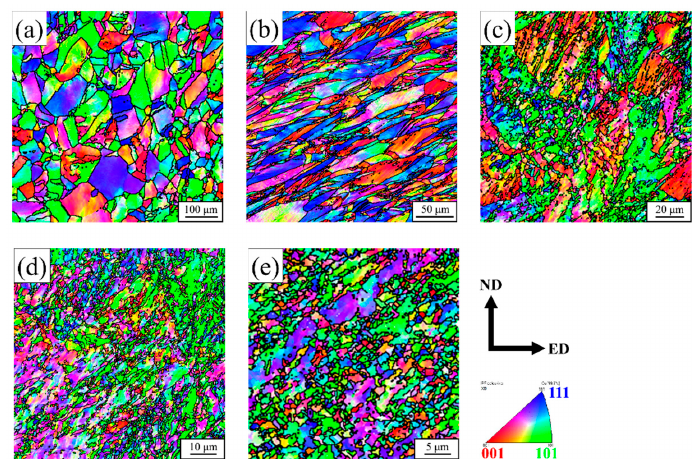
Figure 4. Inverse pole figure (IPF) coloring maps in the central region on the longitudinal section of the ECAPed Cu-Mg alloy: ( a ) 1, ( b ) 2, ( c ) 4, ( d ) 6 and ( e ) 8 ECAP passes.